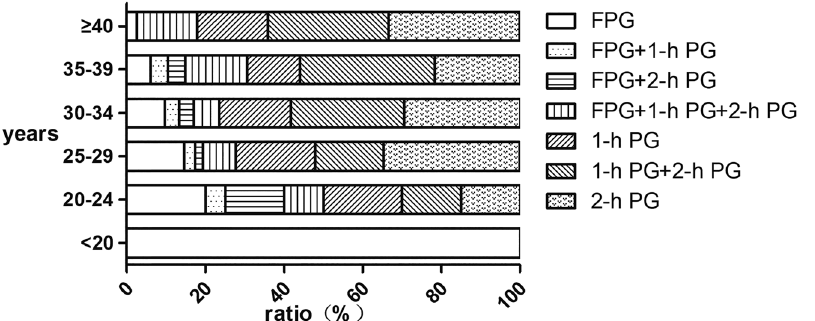
Figure 5: The proportion of plasma glucose values exceeded diagnostic criteria. Furthertoexplore525pregnantwomendiagnosedasgestationaldiabetesmellitus(GDM)afteroralglucosetolerancetest(OGTT)accordingto theInternationalAssociationofDiabetesandPregnancyStudyGroups(IADPSG)criteria.Thatanyofthefollowingvaluesismetorexceededin then75gOGTT:fastingplasmaglucose(FPG) ≥ 5.10mmol/L,1h-postprandialglucose ≥ 10.00mmol/Land2hPG ≥ 8.50mmol/Lwasdiagnosed with